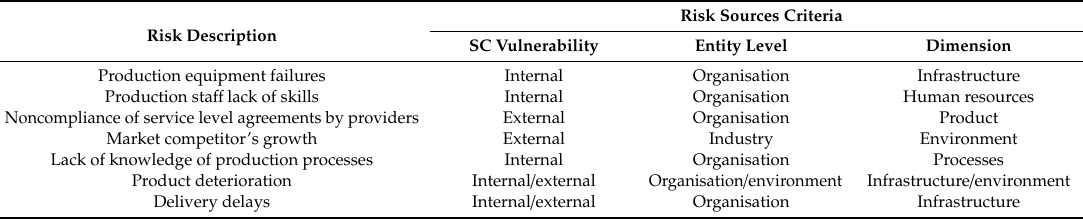
Table 4. Risks considered during stage 3 of SCOP-R applied to the case study. The cells show the risk source for each criterion indicated in the columns, for each risk described in the